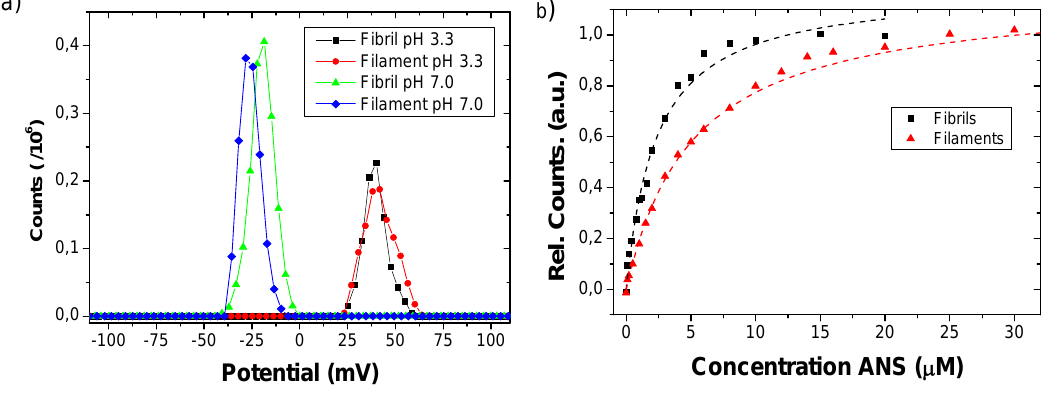
Figure 2. ( a ) Zeta potential measurements of insulin amyloidic fibrils and filaments with distributions determined at pH 7.0 (NaPi) and pH 3.3 (acetic acid); ( b ) Binding of ANS at pH 7.4 to insulin fibrils and filaments as judged from the onset of